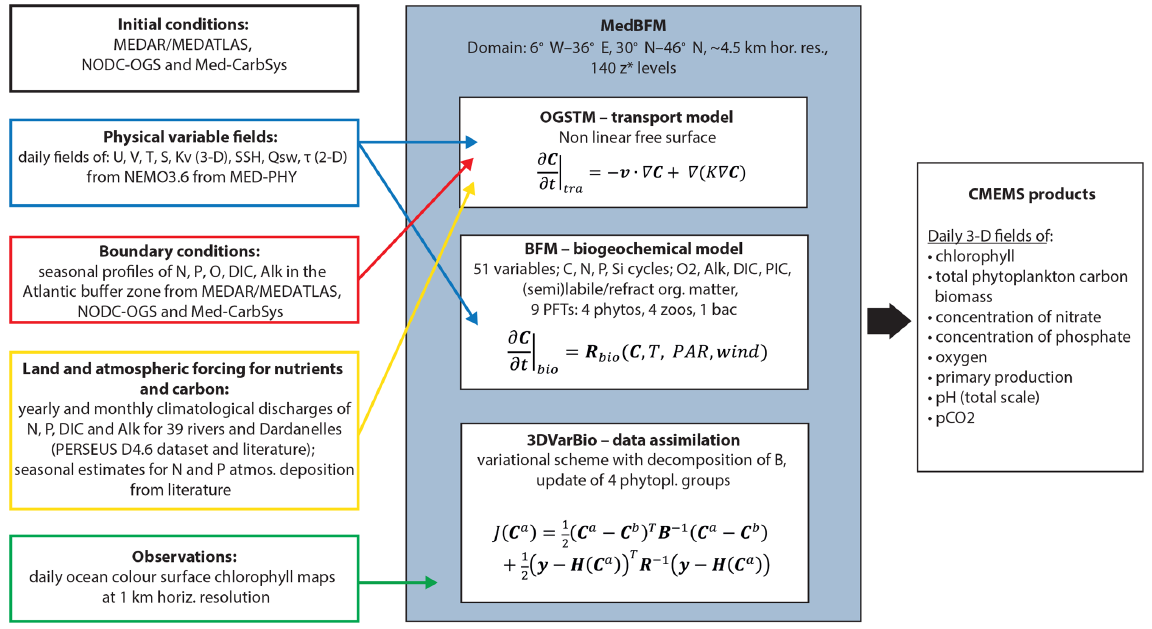
Figure 1. The MedBFMv2.1 model system and interfaces with other components of CMEMS and external forcing